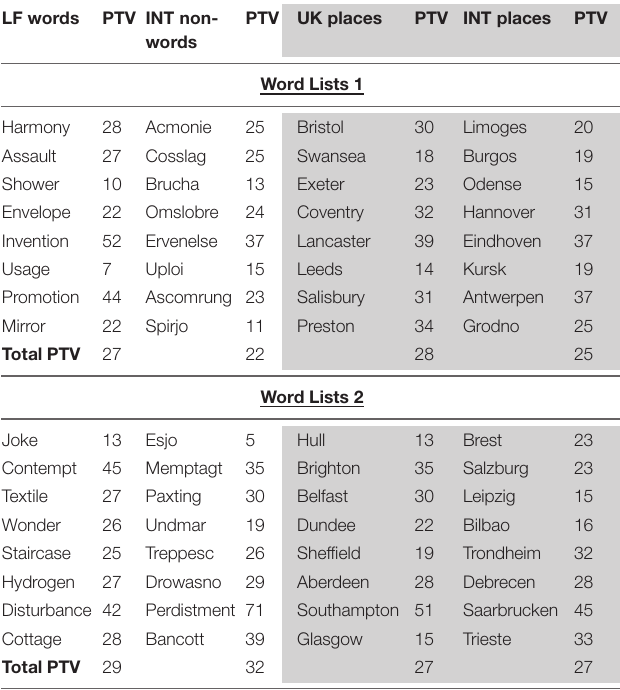
TABLE 2 | Word Lists: low frequency words, international non-words, UK places and INT places. LF words PTV INT non-